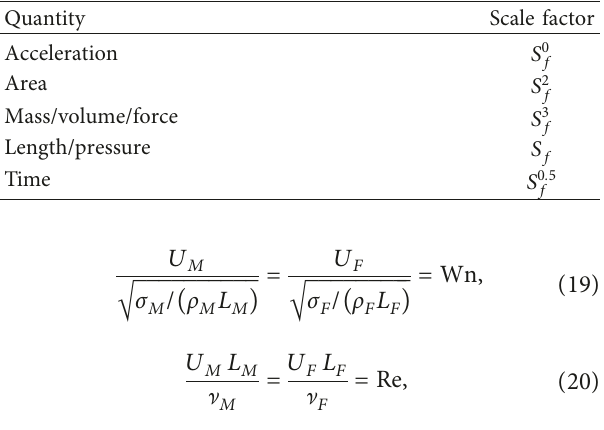
Figure 7: Comparison of the pressure at two different heights. Table 3: Scale factors by Froude